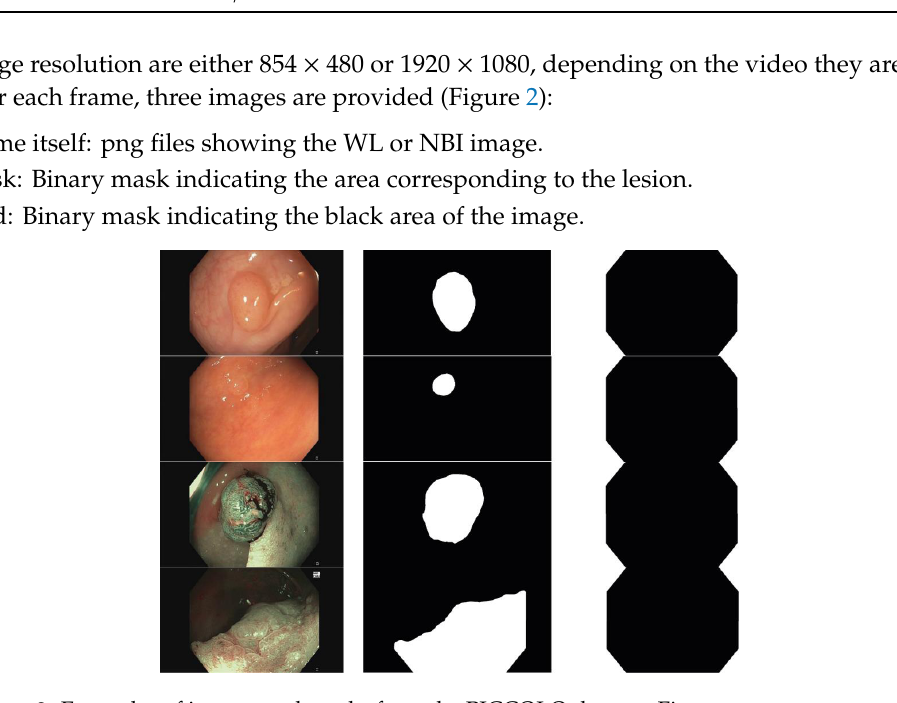
Table 1. Lesions and frames in the PICCOLO dataset according to clinical metadata.